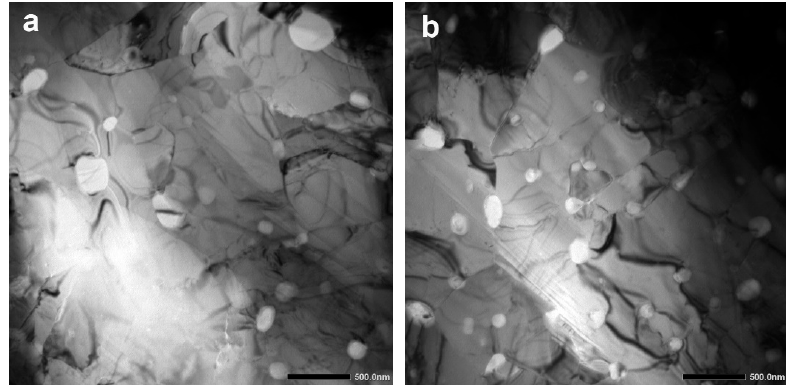
Figure 9. ( a , b ) Two typical bright field images of top layer after serious deformation.